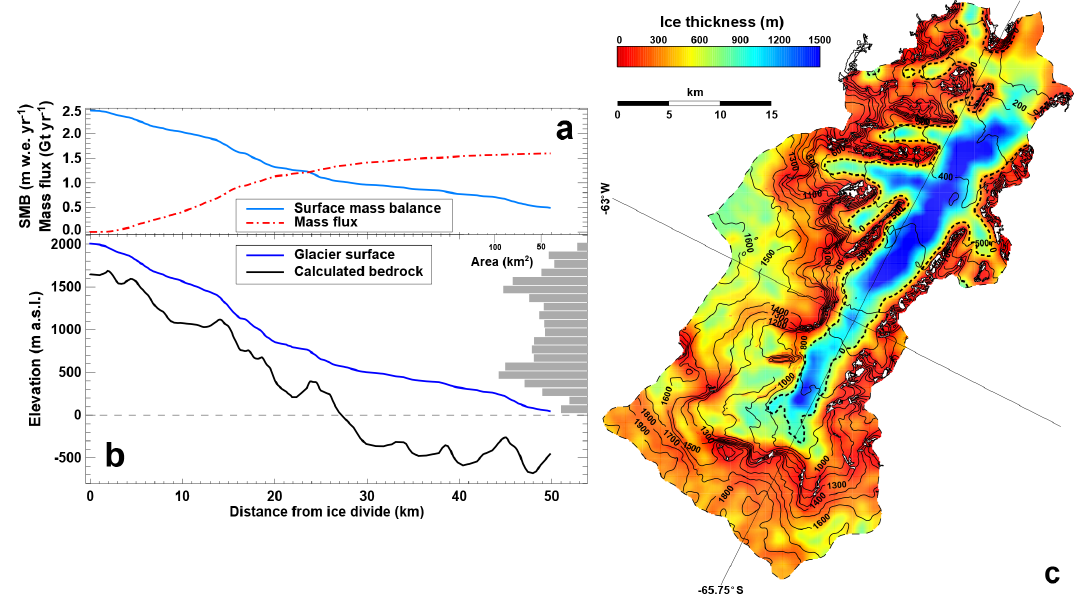
Figure 2. (a) Surface mass balance and mass flux along Flask Glacier (see Fig. 1 for location) according to RACMO (Lenaerts et al., 2012). (b) Surface topography and calculated bedrock (mean of surface elevation bins). The glacier hypsometry is shown by bars. (c) Calculated ice thickness distribution. The spacing of ice surface contours is 100m. The bedrock elevation corresponding to sea level is indicated by the solid dashed